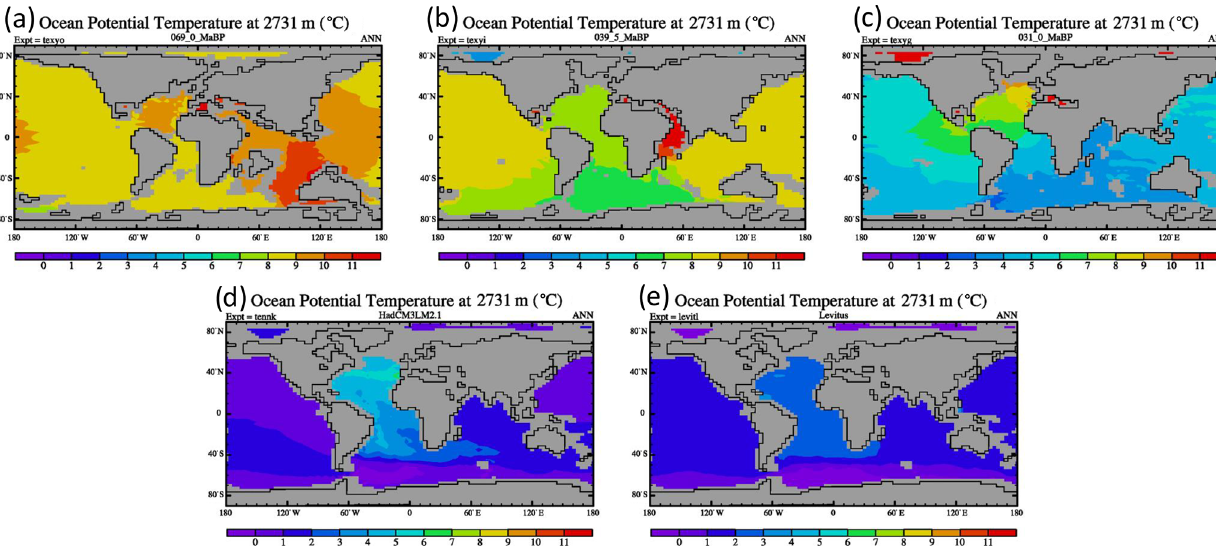
Figure 5. Modelled annual mean ocean temperatures at 2731m depth for three examples of past time periods. Panel (a) is for the Late Cretaceous, panel (b) is for the late Eocene (39.5Ma), and panel (c) is for the Oligocene (31Ma). These are results from the smooth CO 2 set of simulations which agree better with the observed benthic temperature data. Also included are (d) the pre-industrial simulations and (e) the World Ocean Atlas 1994 observational data, provided by the NOAA-ESRL Physical Sciences Laboratory, Boulder, Colorado, from their website at https://psl.noaa.gov/ (last access: 30 June 2021). The thin black lines show the coastlines, and the grey areas are showing where the ocean is shallower than